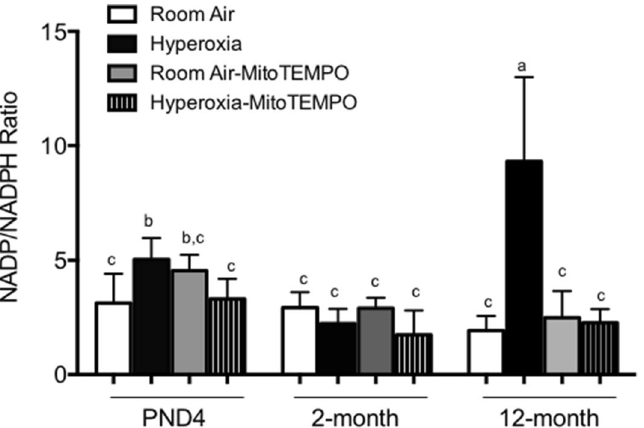
Figure 7. MitoTEMPO blunts NADPH oxidase activity in mice exposed to hyperoxia. The ratio of oxidized NADP and reduced NADPH was measured in homogenized lungs collected from PND4, 2 month, and 12 month mice exposed to room air or hyperoxia and administered mitoTEMPO or vehicle control. Values represent mean + /- SEM ratio of NADP/NADPH per milligram of whole lung tissue collected from 4–5 mice per group. Statistical significance is comparisons for all pairs using Tukey–Kramer HSD test. Bars with the same letter are not significantly different while bars with different letters are significantly different between each